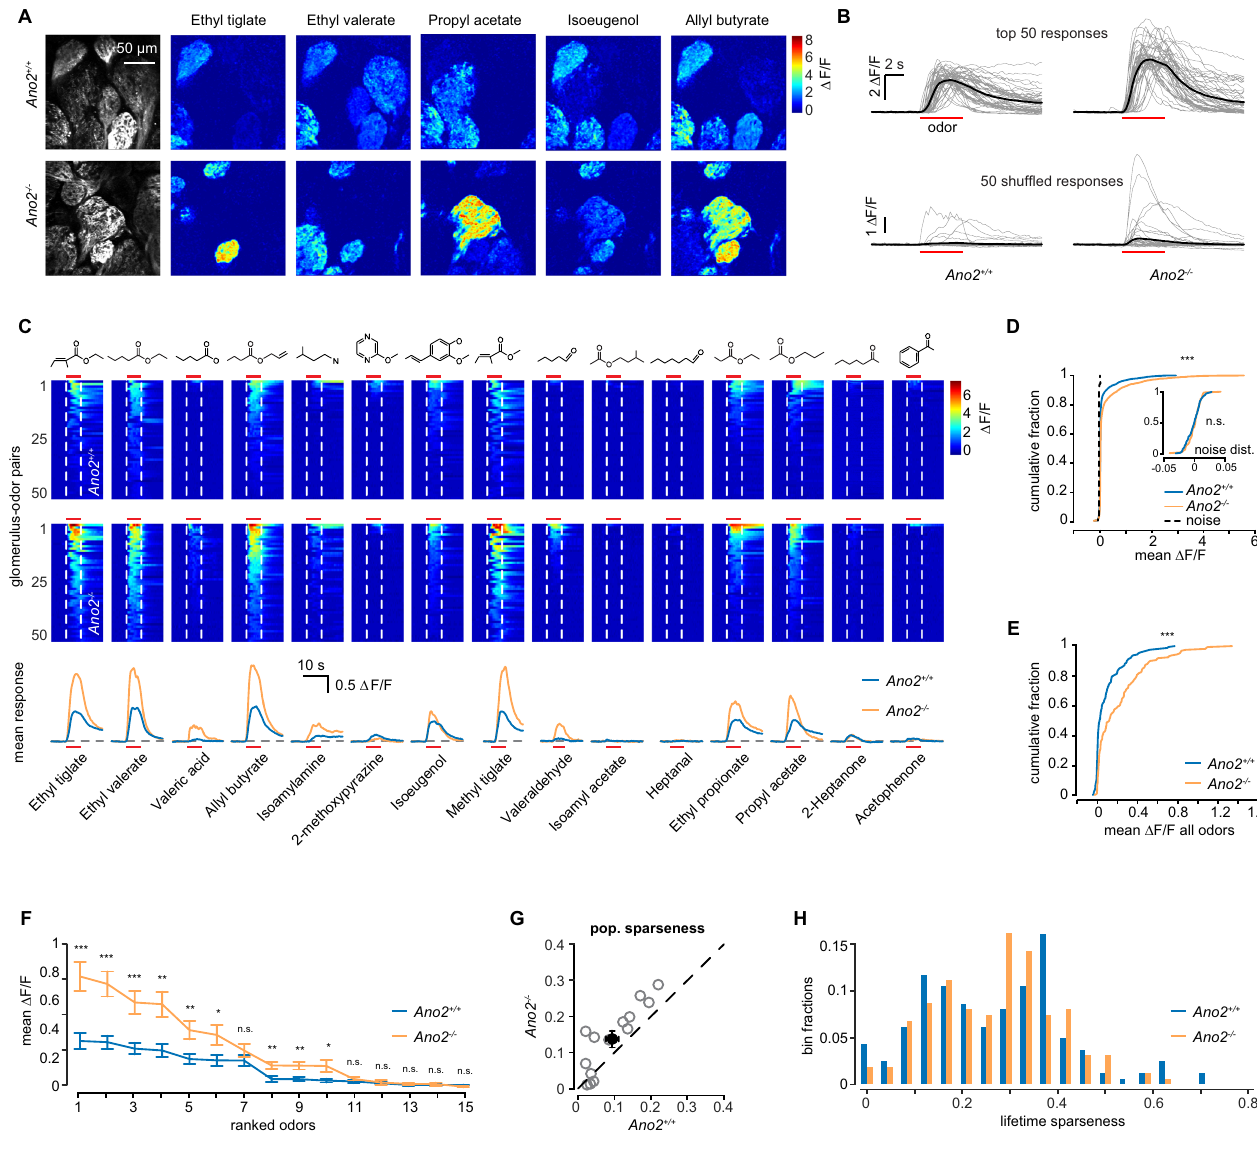
Figure 4. Calcium responses in ORNs measured with multiphoton microscopy. ( A) Example multiphoton- acquired images of glomeruli from an example Ano2 + / + and Ano2 − / − animal, as well as example Δ F/F responses for five selected odors. Mean images from 20 frames preceding and during the odor delivery period were used. ( B) Traces of the 50 largest (top) Ca 2 + responses for Ano2 + / + and Ano2 − / − animals across all odors and 50 randomly selected responses (bottom). ( C) The 50 largest odor-evoked Ca 2 + signals across all animals for each of 15 odors. Dashed line denotes odor onset and offset and red bar indicates odor duration. Molecular structures are depicted above. Bottom, mean response time course for each odor. ( D) Cumulative distribution of the mean Ca 2 + response in the odor period across all glomerulus-odor pairs (n = 2430 Ano2 + / + and 2415 Ano2 − / − glomerulus-odor pairs, p < 0.001, Kolmogorov–Smirnov test). Inset, distribution of blank odor trial responses used to determine ROC threshold (threshold = 0.02 n = 162 Ano2 + / + and 161 Ano2 − / − glomeruli, p > 0.05, Kolmogorov–Smirnov test). ( E) Cumulative distribution of the mean Ca 2 + response across all odors at each glomerulus (n = 162 Ano2 + / + and 161 Ano2 − / − glomeruli, p < 0.001, Kolmogorov–Smirnov test). ( F) . Mean response of all glomeruli responding above threshold for each odor (Wilcoxon rank-sum test with Bonferroni correction, * p < 0.05, ** p < 0.01, *** p < 0.001). ( G) Scatter plot of population sparseness for each odor. Mean across all odors is the filled black circle (mean sparseness = 0.09 ± 0.02 in Ano2 + / + and 0.13 ± 0.02 in Ano2 − / − , p = 0.002, Wilcoxon sign-rank test). ( H) Histogram of lifetime sparseness across all glomeruli (mean sparseness = 0.28 ± 0.01 in Ano2 + / + and 0.28 ± 0.01 in Ano2 − / − , p = 0.89, Wilcoxon rank-sum